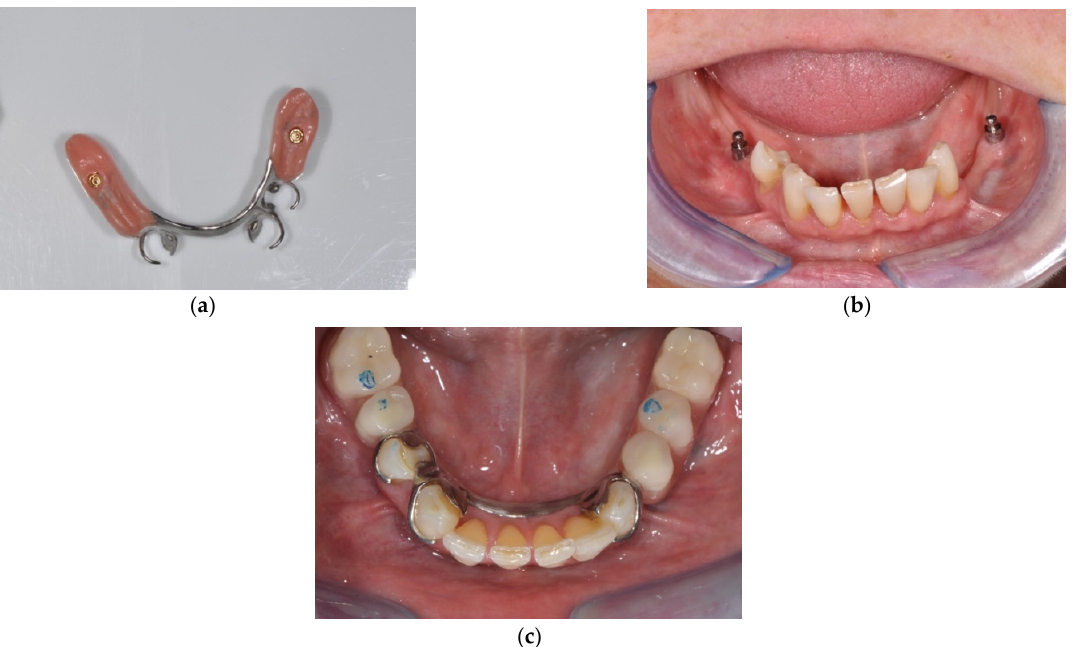
Figure 3. ( a ) Extraoral view of the converted prosthesis including the matrices for the ball abutments; ( b ) intraoral view with ball abutments mounted on the implants; ( c ) intraoral view of the converted implant-assisted removable partial denture.